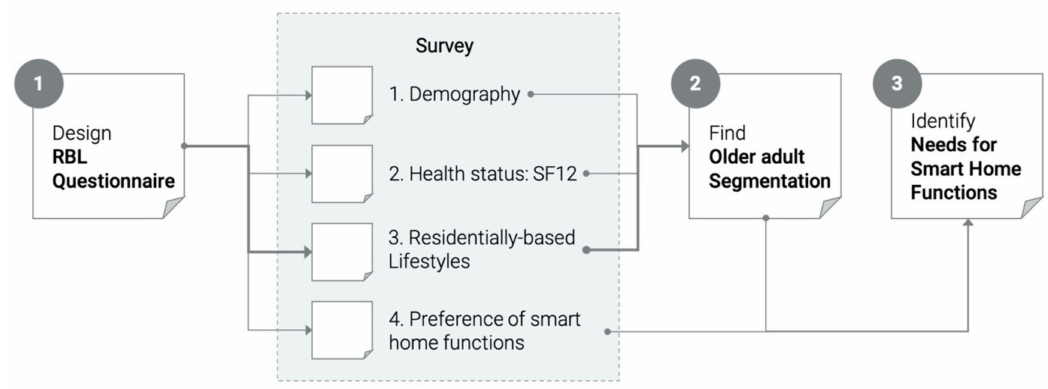
Figure 1. Research process and